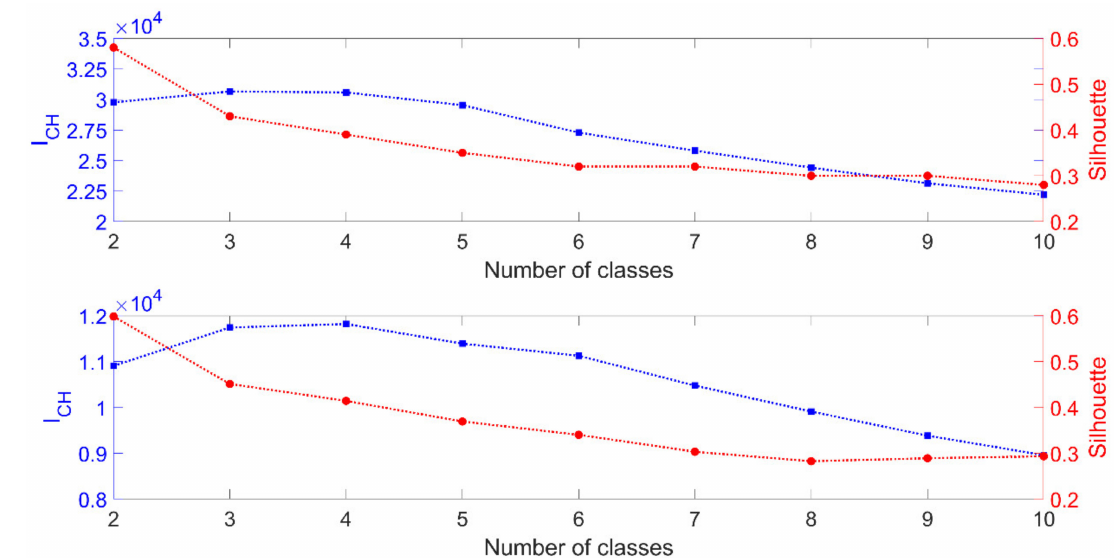
Figure 2. Evolution of the Calinski–Harabasz criterion ( I CH in blue) and the silhouette (in red) criterion as a function of the number of classes for ENVISAT (upper panel); Jason-2 (lower panel) backscattering coefficients.